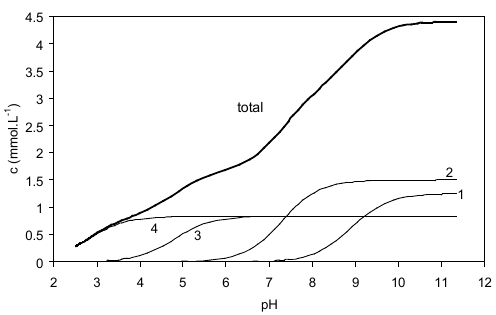
Figure 3. Calculated distribution of the active sites (non-protonated forms) on the surface of activated carbon (for 1 L of water and 10 g of activated carbon) = adsorption capacity towards positive charged ions at various pH values.